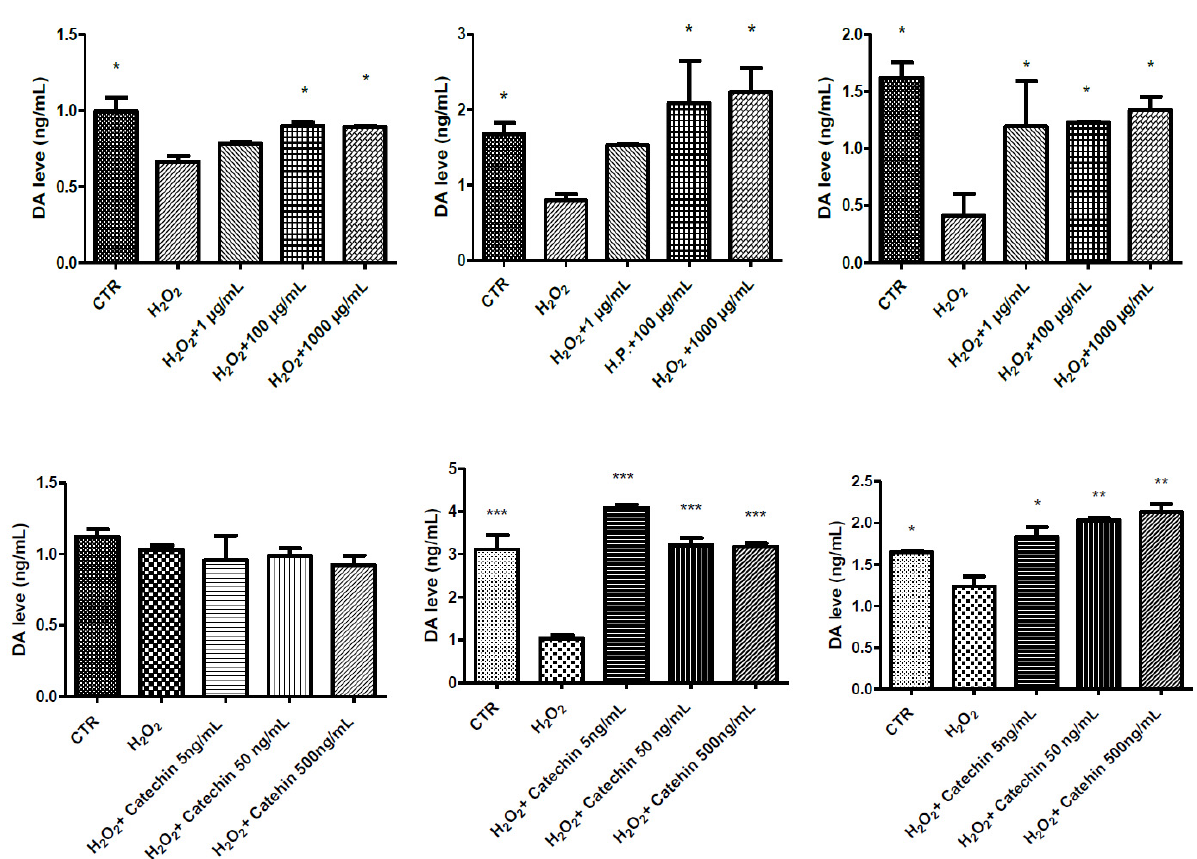
Figure 4. Inhibitory effects exerted by grape pomace water extract (1–1000 µ g/mL) and catechin (5–500 ng/mL) on hydrogen peroxide (H 2 O 2 )-induced reduction of dopamine (DA) extracellular levels (ng/mL) in HypoE22 cells. The efficacy of the extract was evaluated at different time points: 24 h ( left ); 48 h ( middle ); 72 h ( right ). ANOVA, p < 0.0001; * p < 0.05, ** p < 0.01, *** p < 0.001 vs. respective hydrogen peroxide (H 2 O 2 ) group.